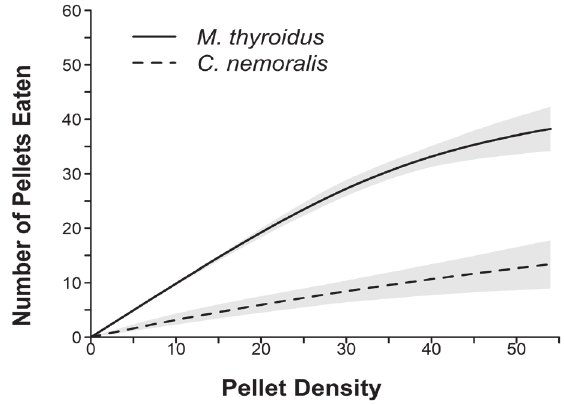
Figure 1. Fitted functional response curves of native M. thyroidus (solid line) and introduced C. nemoralis (dashed) with 95% CI bands (grey).